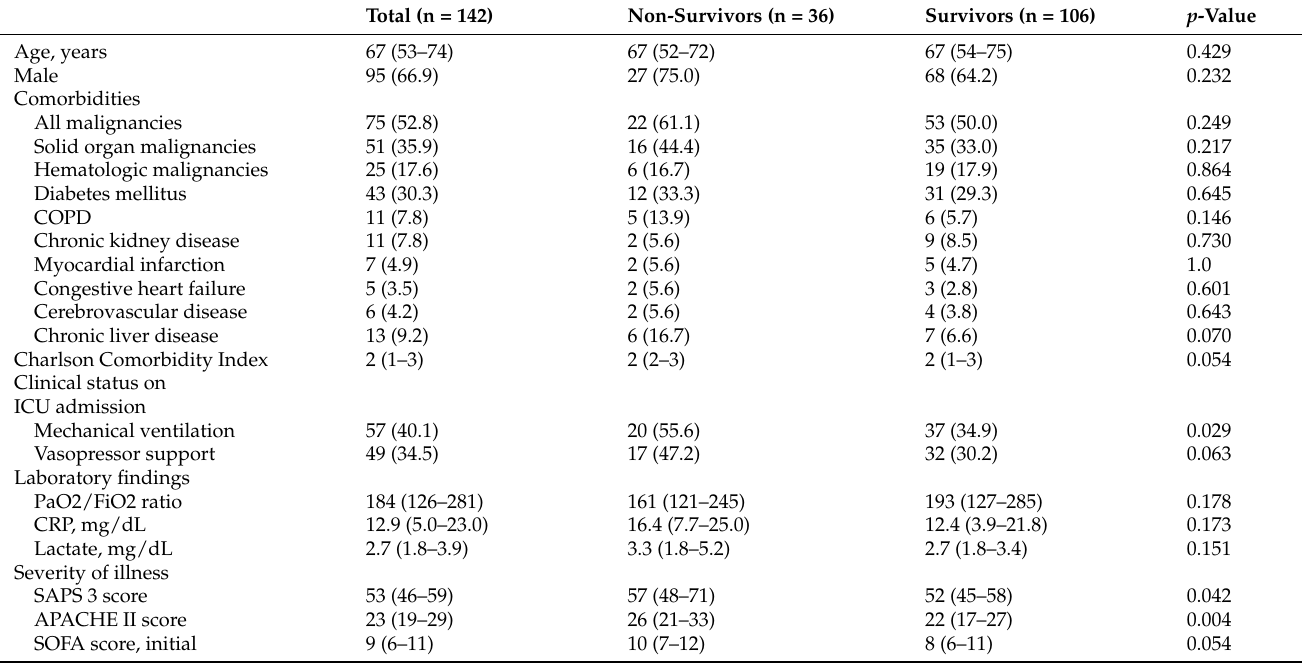
Table 1. Characteristics of the study population. Data are presented as number (percentage) or median (interquartile